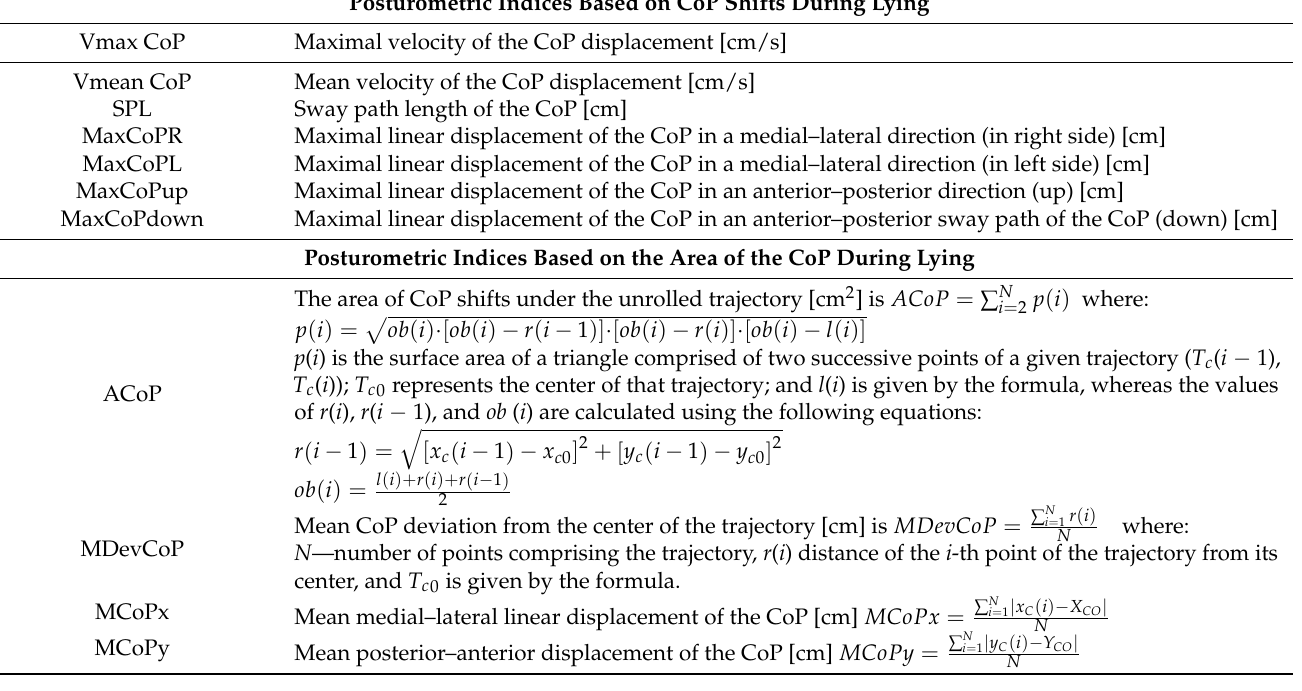
Table 2. Posturometric indices based on CoP shifts and posturometric indices based on the surface area of the CoP during